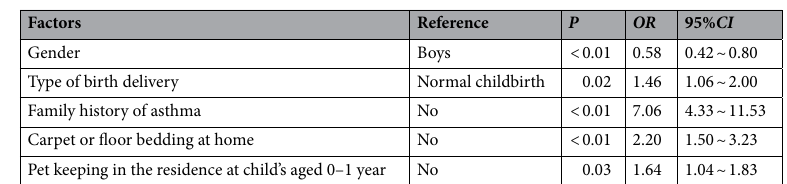
Table 4. Multivariate logistic regression analysis of risk factors for asthma among preschool children in Urumqi ( n = 8153). OR odds ratio, CI confidence interval.